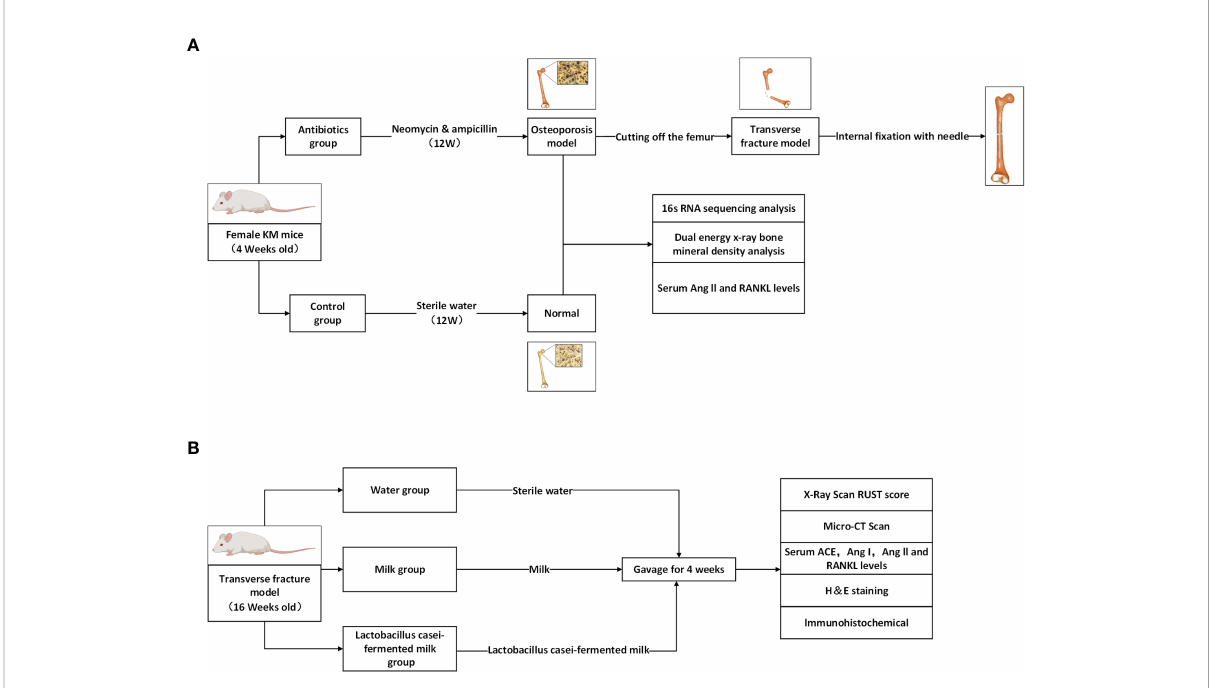
FIGURE 1 Schematic diagram of the process designed for this study. (A) Antibiotic feeding induced osteoporosis model establishment in mice. (B) Antibiotic group mice were randomly divided into 3 groups and given different interventions, and the corresponding indexes were tested after 4